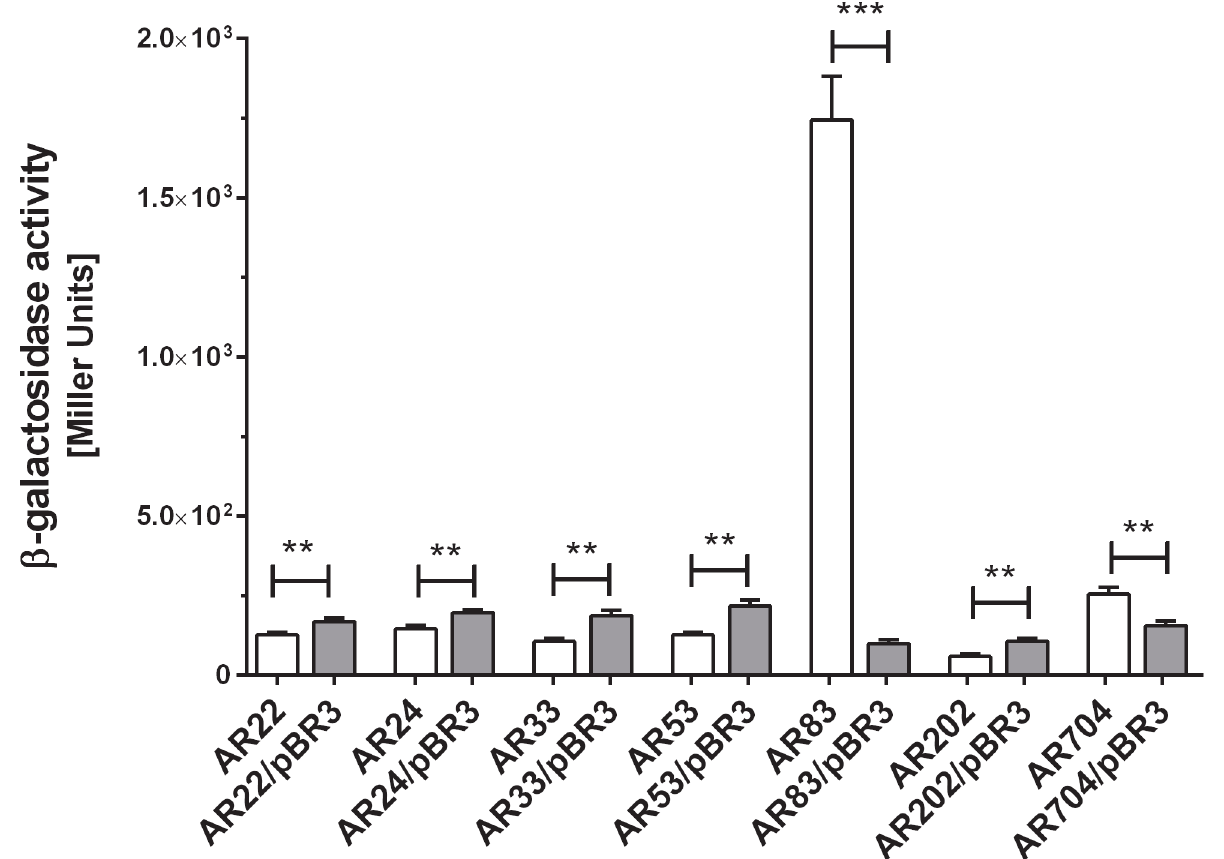
Fig 1. β -galactosidase activity exhibited by different transposon mutants and trans -complemented strains. The data represent mean values ( ± standard deviation) from three independent experiments performed in triplicate. Asterisks indicate statistically significant differences ( ** — p < 0.01; *** — p < 0.001) according to Student ’ s unpaired t -test.